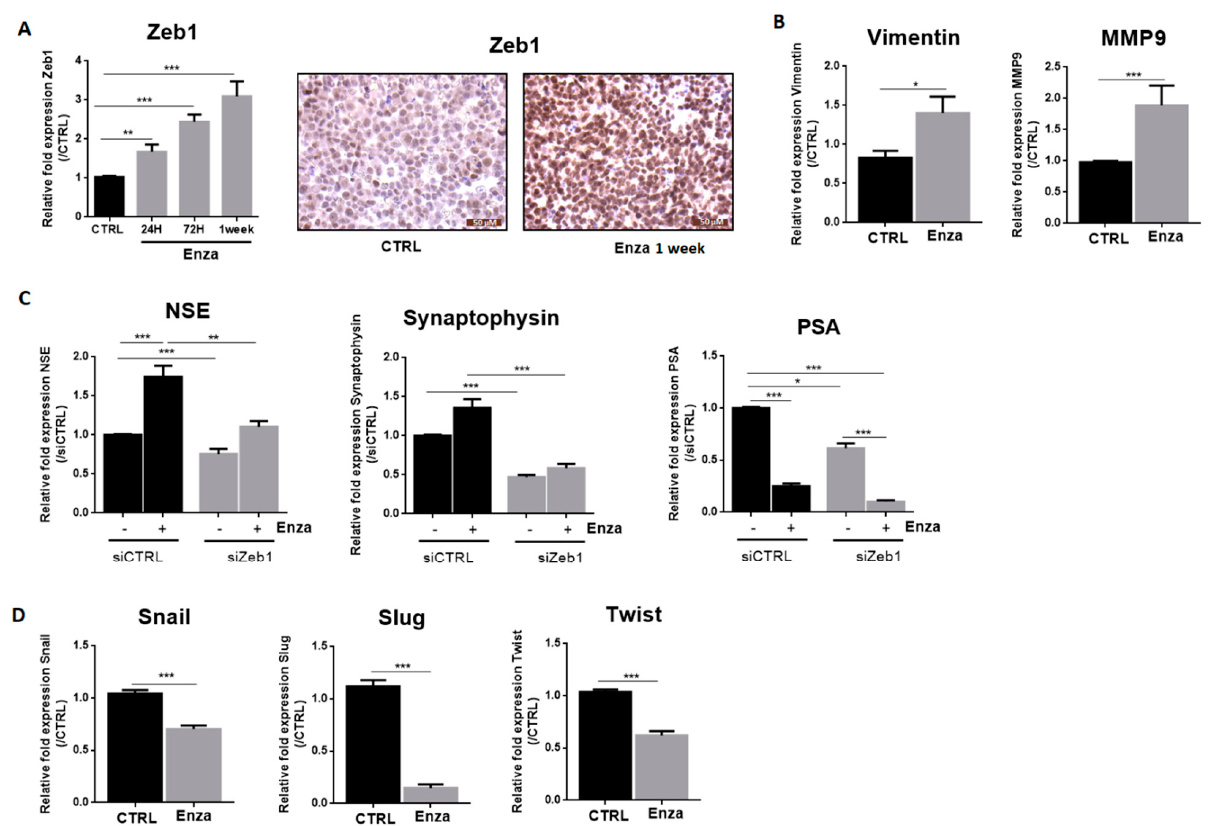
Figure 3. NED induced by AR inhibition depends on the EMT transcription factor, Zeb1. Graphs represent qPCR results and pictures represent immunohistochemistry results. All Enza treatments (10 µ M) were performed for one week except in the cases indicated. ( A , B) : Enza increases Zeb1 and its target genes expression; ( C ): Effects of Zeb1 inhibition on neuroendocrine markers and PSA expression. LNCaP cells were treated with Enza (10 µ M) for 1 week and then used for transfection assay performed for 96 h with a siRNA directed against Zeb1; ( D ): Enza decreases the EMT transcription factors Snail, Slug and Twist. qPCR results are normalised to the control condition and are expressed as mean ± S.E.M. The statistical differences are indicated: * p < 0.05; ** p < 0.01; *** p < 0.001 (Mann–Whitney ( B , D ); Kruskal–Wallis; post-test: Dunn ( A , C ) n = 3 for all experiments except for transfection assays, n = 6.